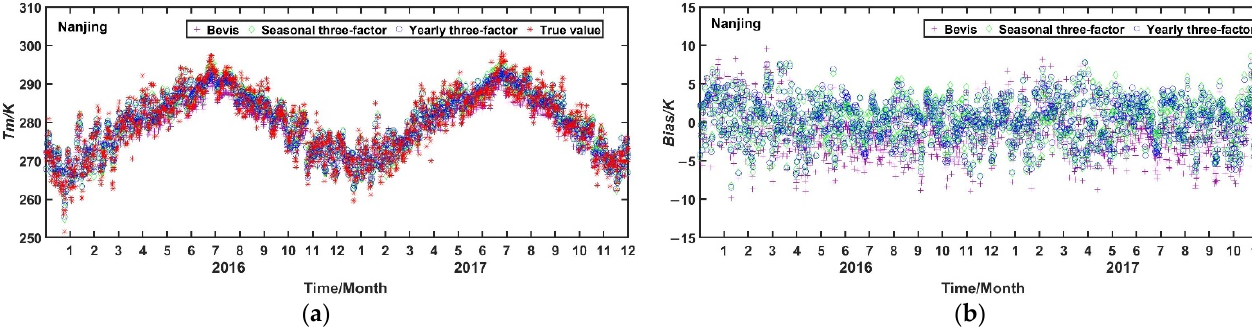
Table 8. Deviation distribution of Bevis model, yearly and seasonal three-factor RTMs (K).